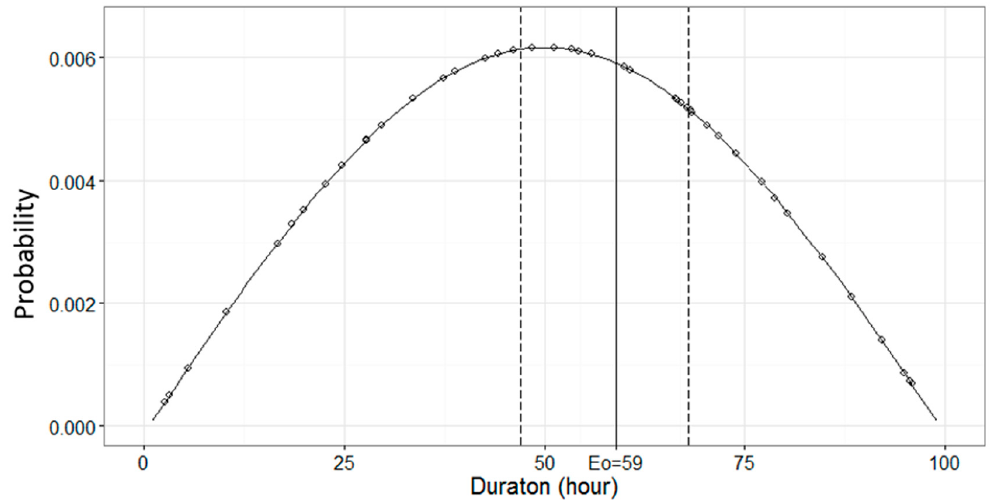
Figure 3. Sample of K nearest neighbors (KNN) on precedent event condition.